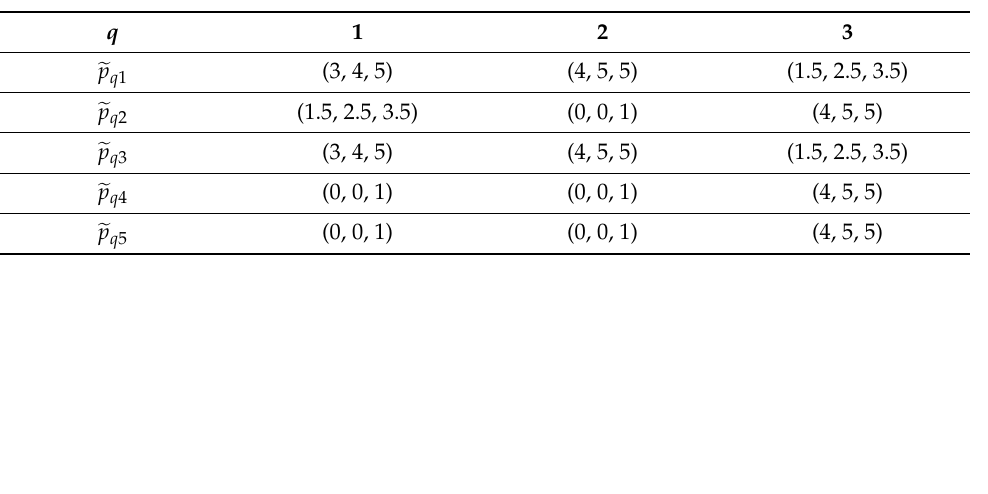
Table 5. Performance of the three alternative suppliers in optimizing various